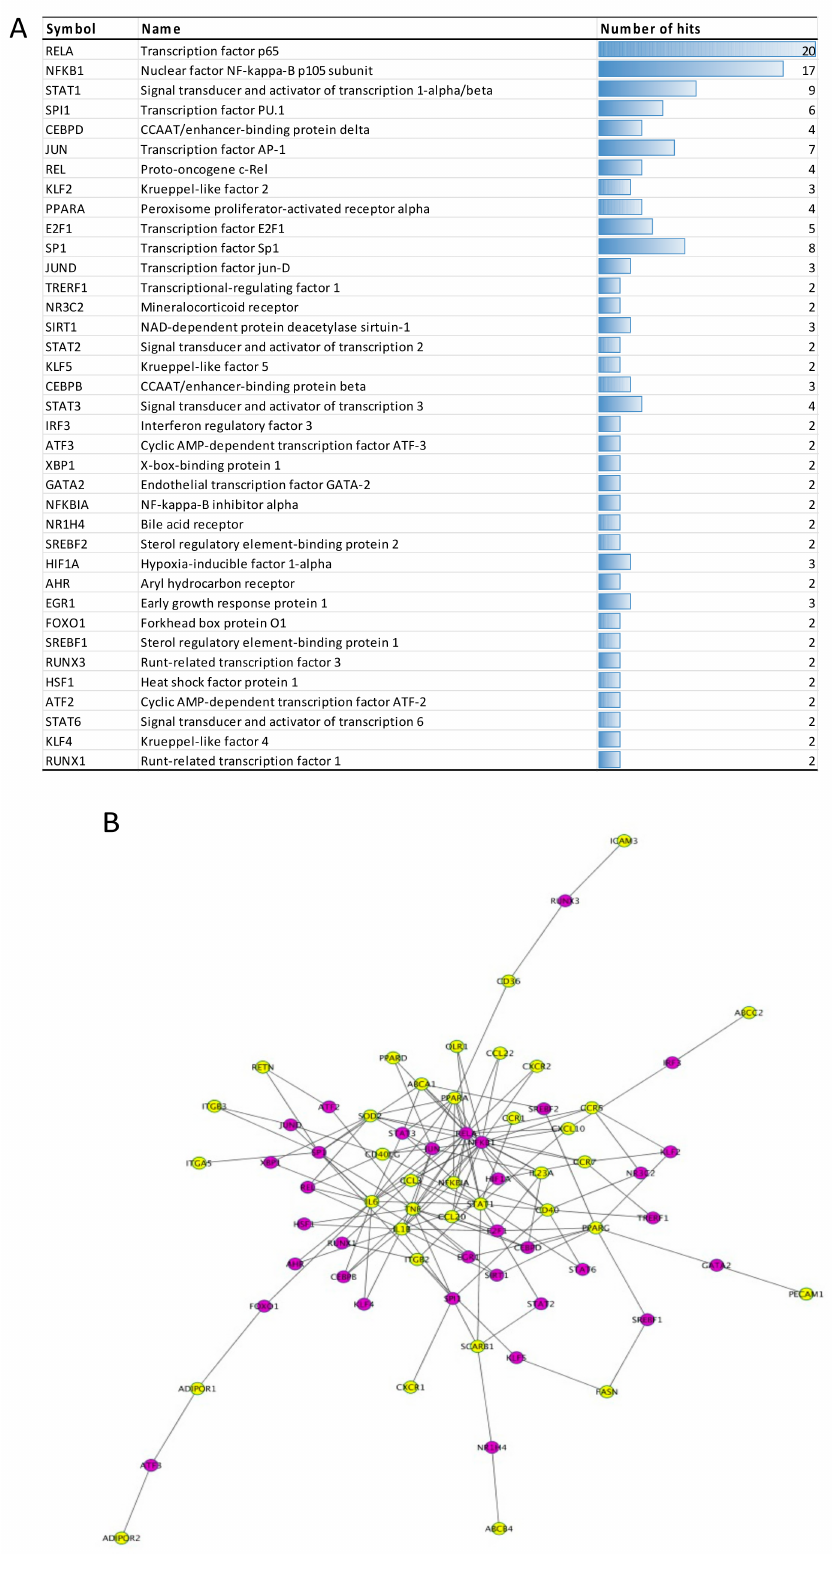
Figure 5. Regulation of differentially expressed mRNAs at the transcriptional level. ( A ) Predicted transcription factors that regulate polyphenol modulated genes, arranged according to their p -values, in ascending order. ( B ) Interconnections between predicted transcription factors (in purple color) and polyphenol modulated genes (in yellow